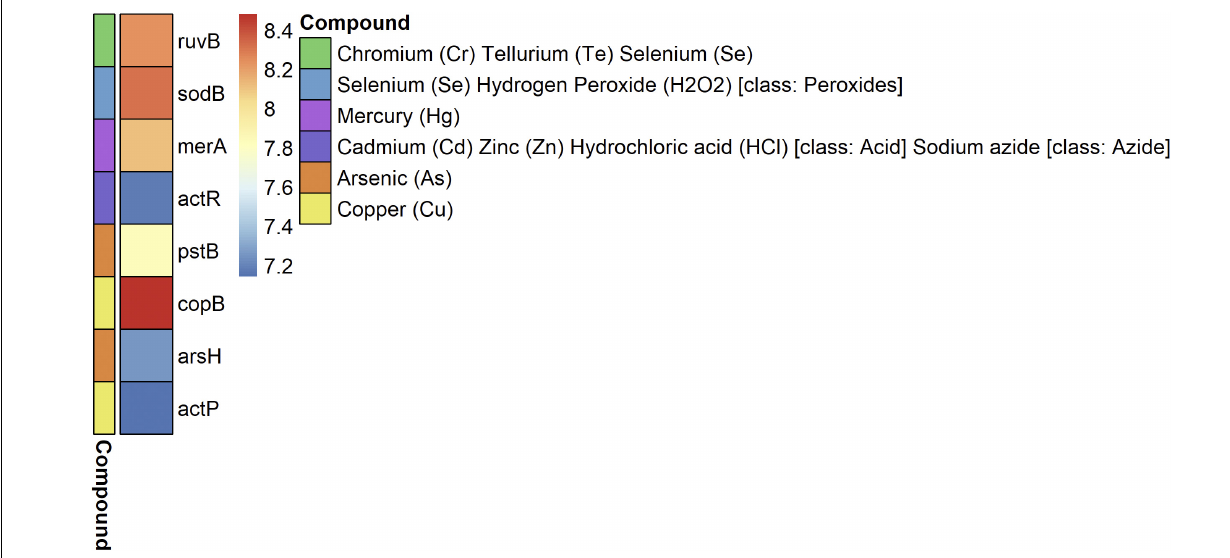
Frontiers in Microbiology |